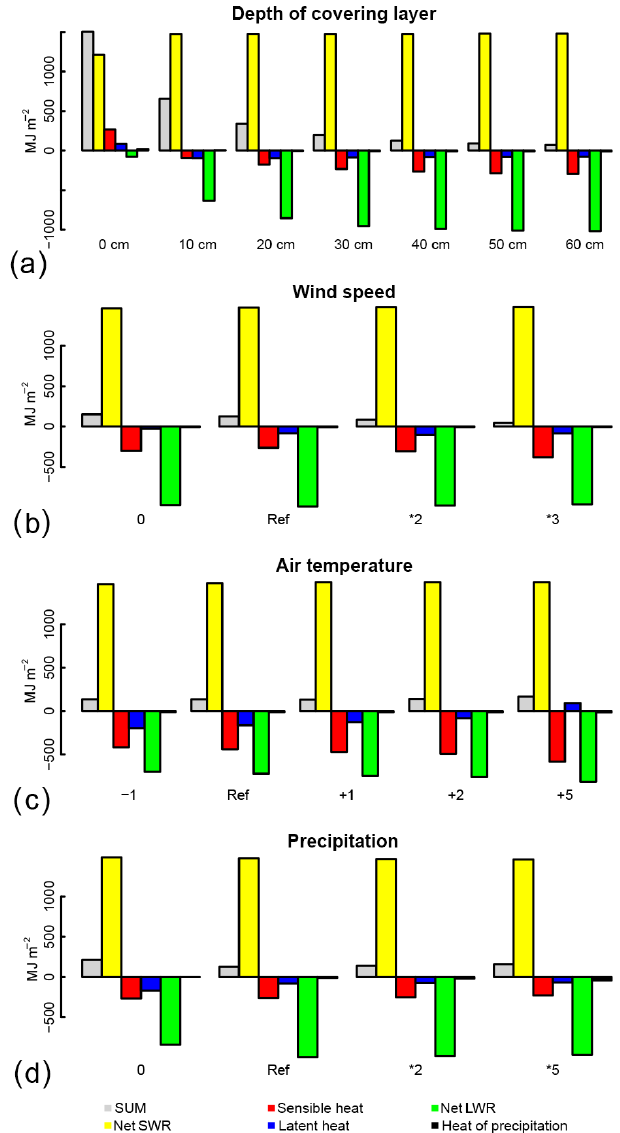
Figure 11. Most important terms of the energy balance of the Flüela snow heap and their contribution to melt for the different model runs of the sensitivity study: (a) depth of covering layer, (b) wind speed, (c) air temperature, (d)